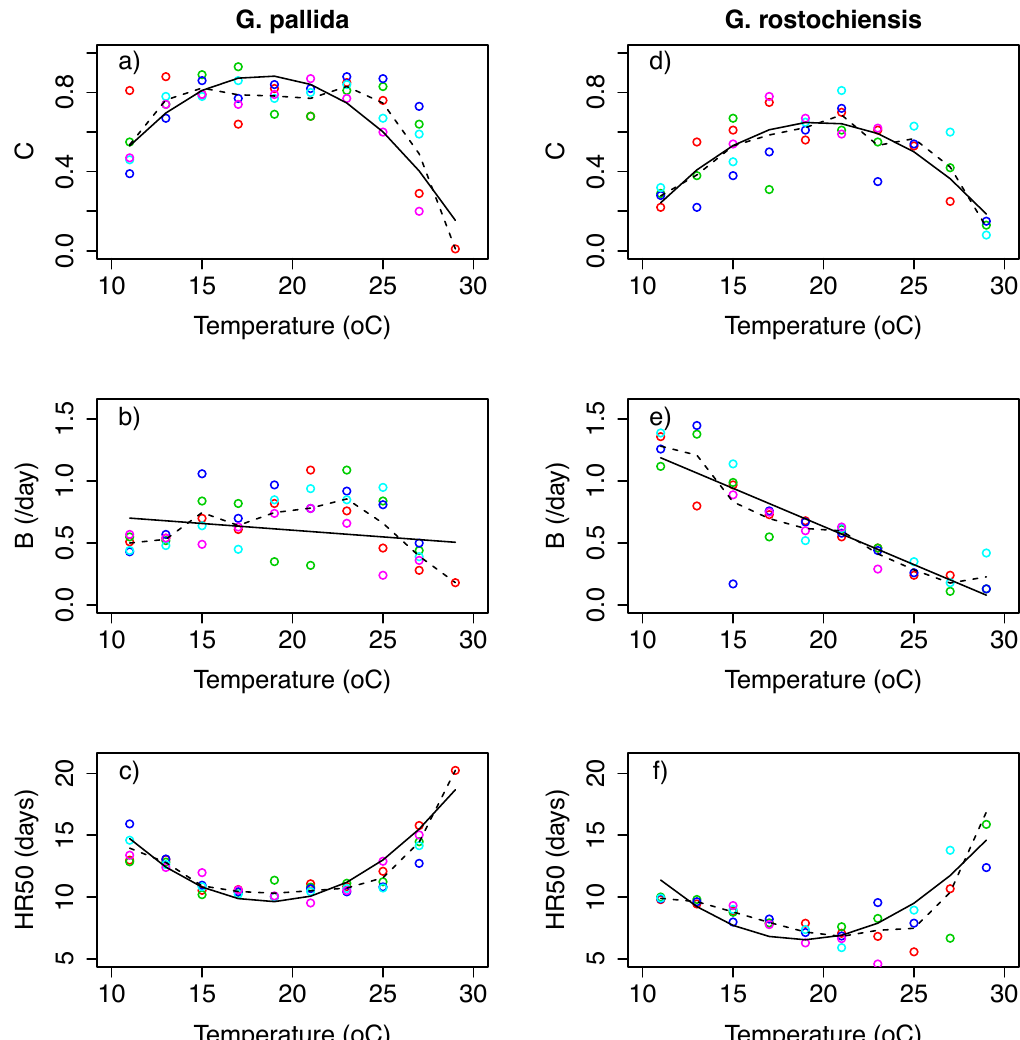
Figure 4. Parameters C, B and M (HR50) for the logistic equation (Y = A + C/(1 + exp(-B(t - M))) ) as a function of tempera- ture for Globodera pallida (left) and G. rostochiensis (right) . Each replicate is shown by the same coloured dots, the dashed line is the mean of the replicates and the solid line is the predicted curve from Equations 2, 3 and